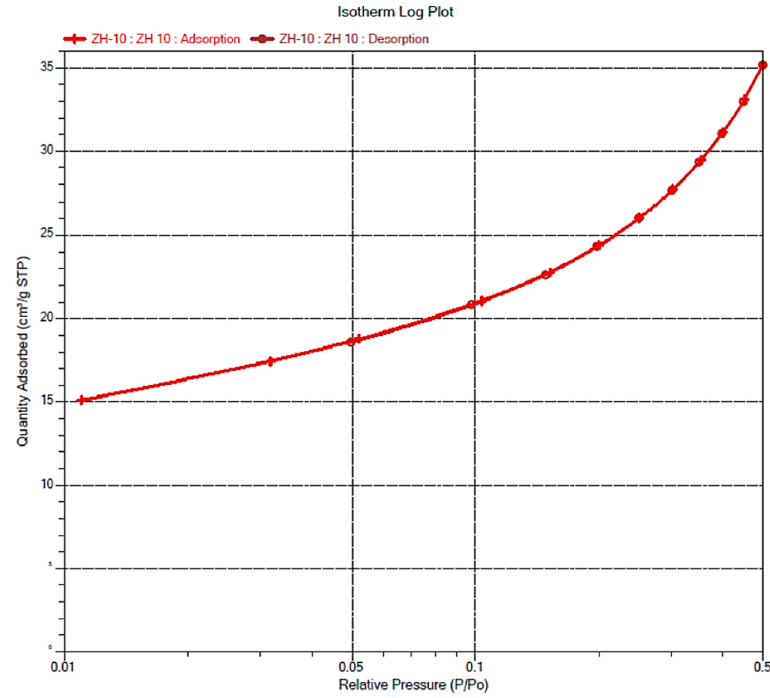
Figure 3. N 2 absorption/desorption curves obtained by BET.